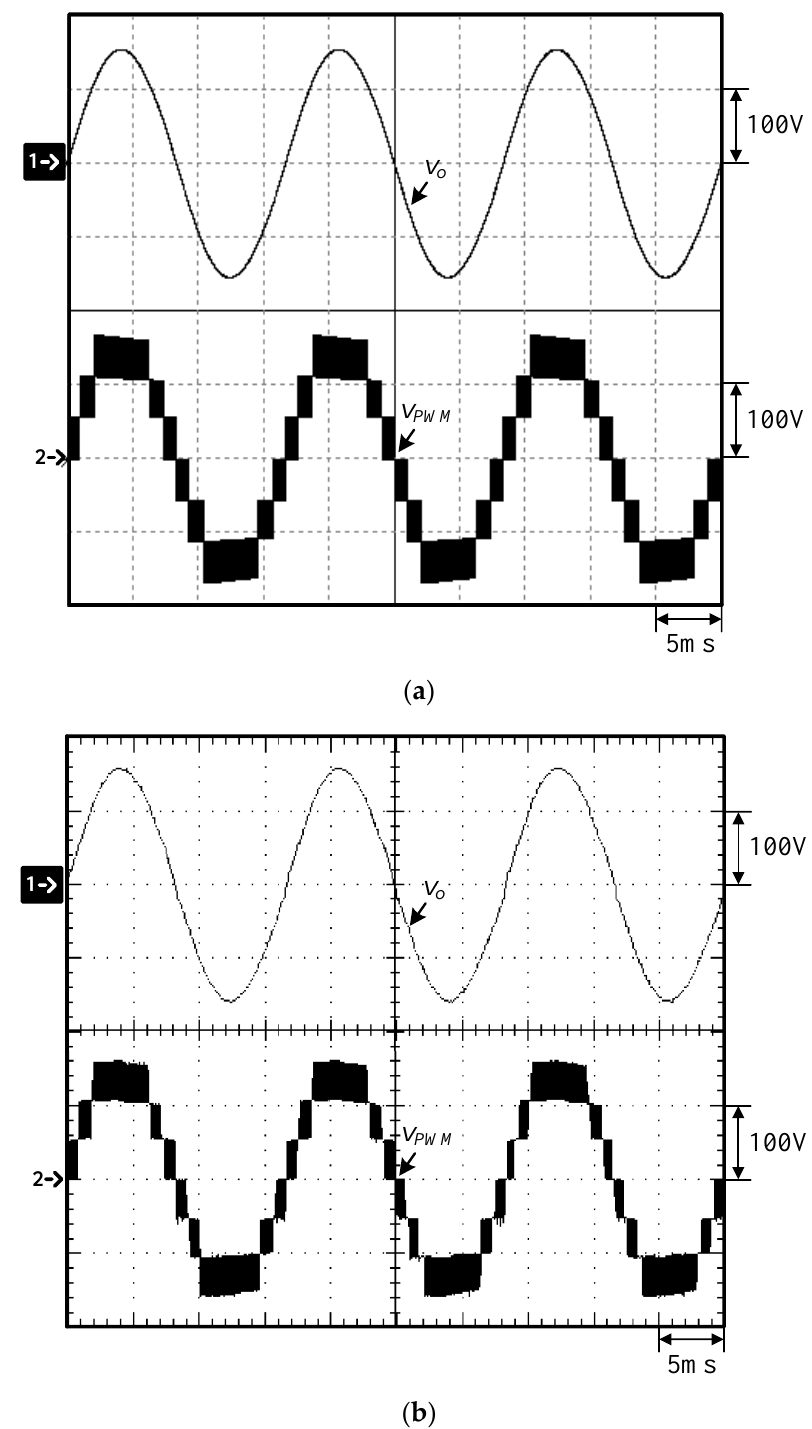
Figure 16. Waveforms at rated load with (1) v o and (2) v PWM : ( a ) simulated; ( b ) measured.